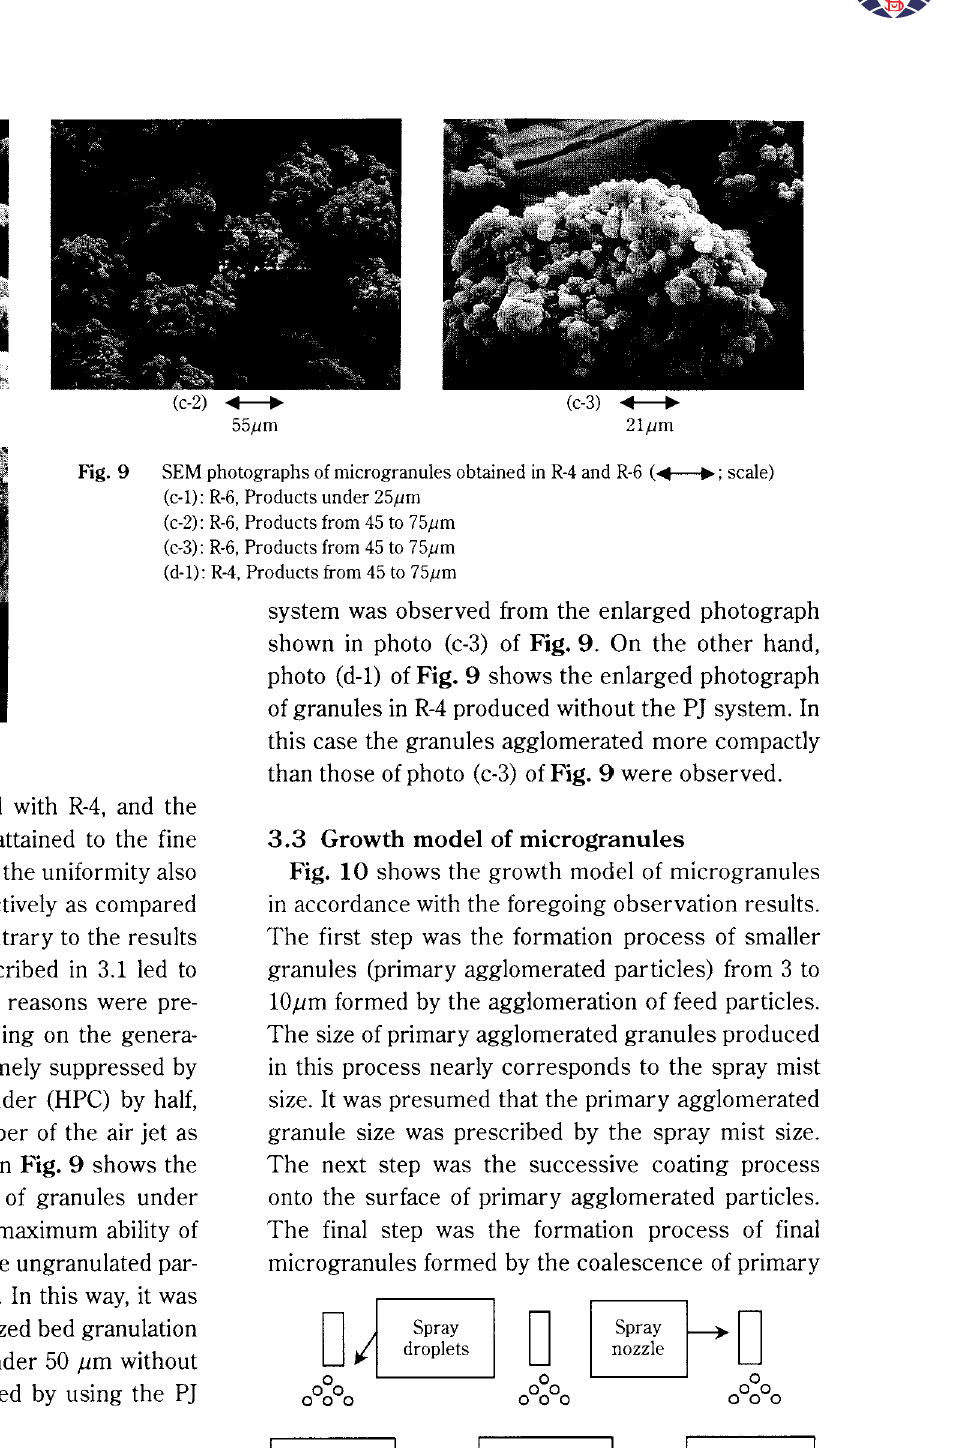
Fig. 10 Schematic diagram of micro granule growth mechanism